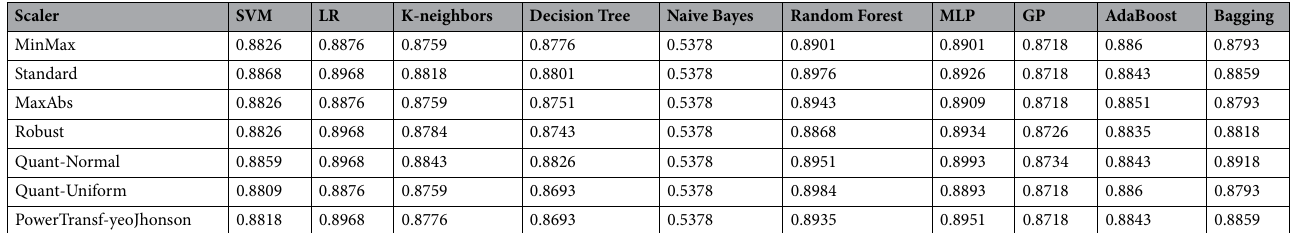
Table 3. Matrix of accuracy results, according to different scales and algorithms.